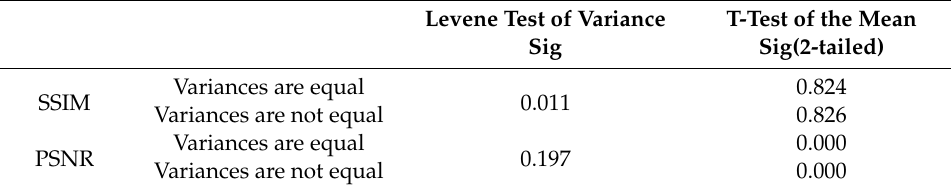
Table 6. T-Test of the model across